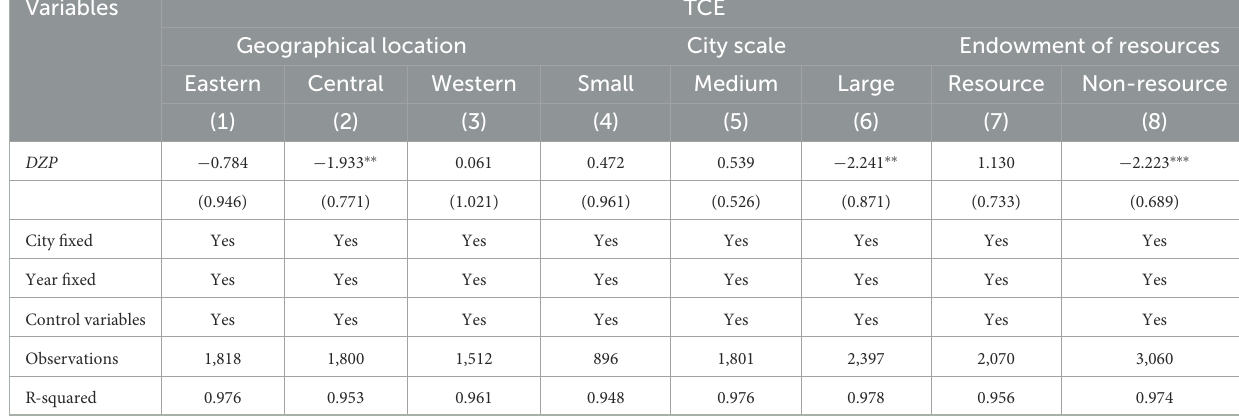
TABLE 7 Heterogeneity test results.